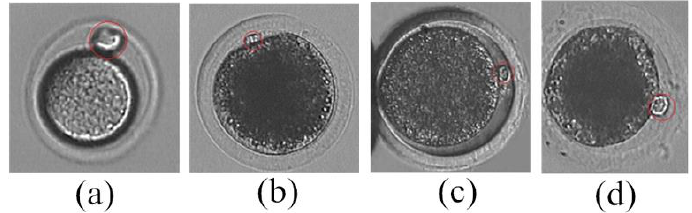
Figure 1. Polar body microscopic image. ( a ) The polar body of a mouse oocyte; ( b–d ) The polar bodies of porcine